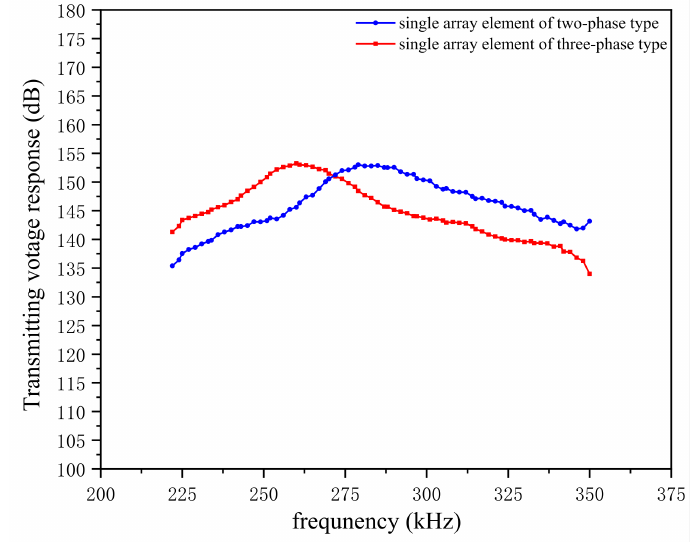
Figure 4. Transmitting voltage response curves of single elements of the two 1–3 piezoelectric composite by simulation.